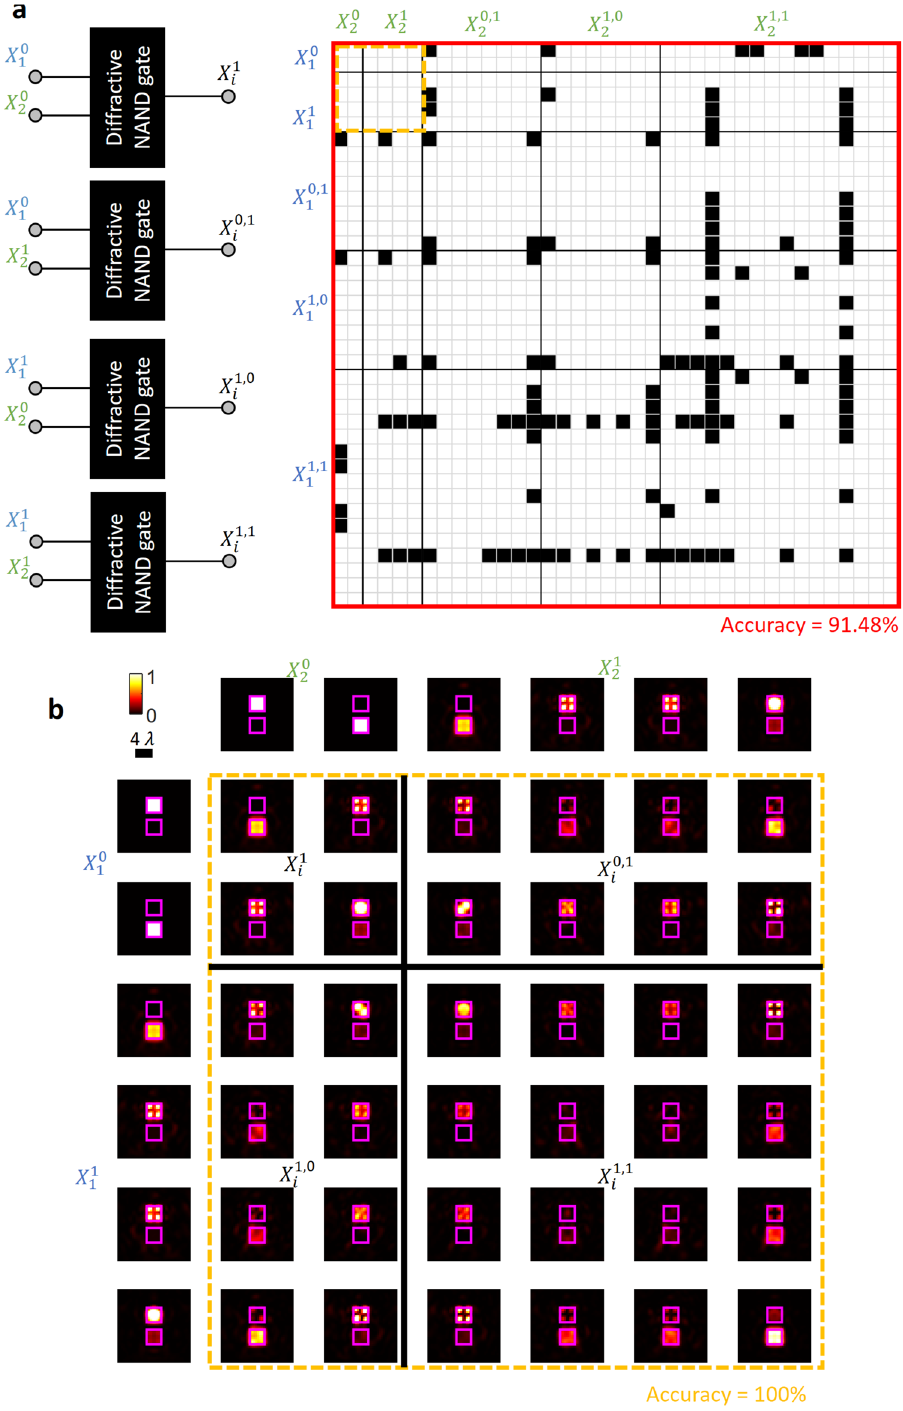
Figure 2. Performance of cascaded diffractive NAND gates. ( a ) A design map for cascading diffractive NAND gates. The black squares indicate the input wave combinations that lead to a miscalculation, i.e., an inference error. ( b ) The output plane intensity profiles of the optical waves that belong to sets x 1 i , x as their corresponding input